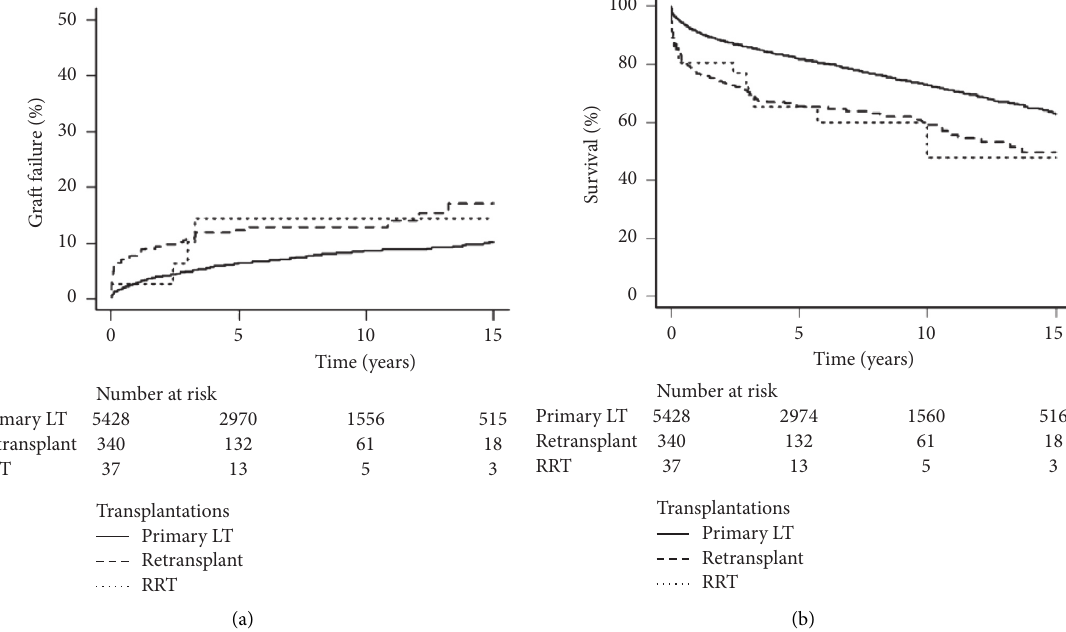
Figure 2: Incidence of graft failure (a) and overall survival (b) by the number of transplantations (LT: liver transplantation; RRT: repeat retransplantation).